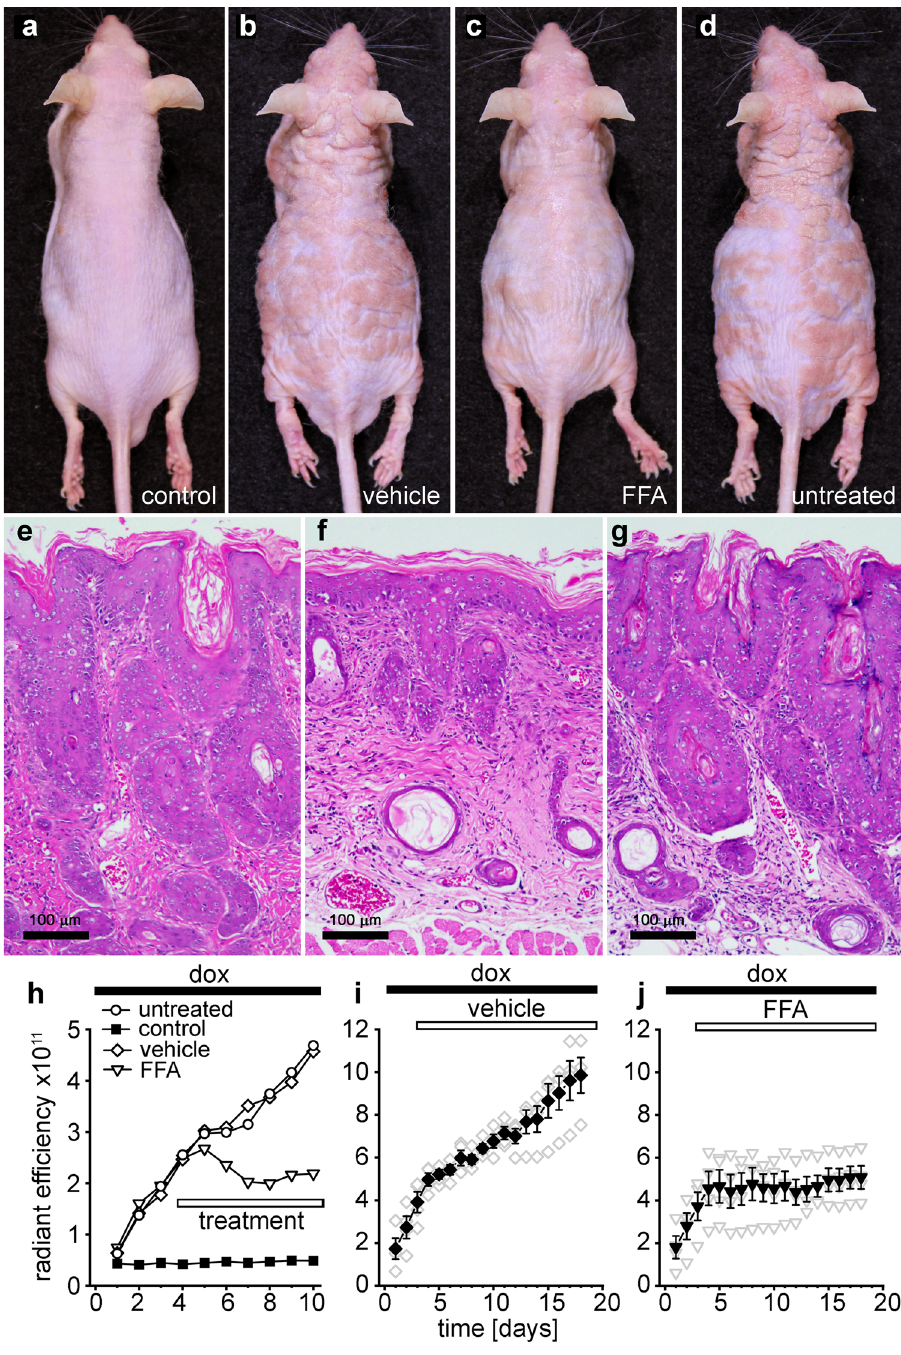
Figure 5. FFA was required for amelioration of KID pathology. ( a – d ), Images of a control wild-type mouse ( a ), a vehicle treated transgenic mouse ( b ), a FFA treated transgenic mouse ( c ) and an untreated transgenic mouse ( d ). FFA treatment reduced ( f ) skin pathology seen in untreated ( e ), or vehicle treated ( g ) transgenic mice. Prior to FFA or vehicle treatment, the radiant efficiency ( h ) increased for all three animals. The mouse topically treated with FFA stabilized at a constant fluorescent value. Radiant efficiency in the untreated, or vehicle treated mice increased. Treatment of groups of animals (n = 4) with vehicle ( i ) or topical FFA ( j ) for 16 days produced similar results. Filled symbols are means ± SE, open symbols are raw